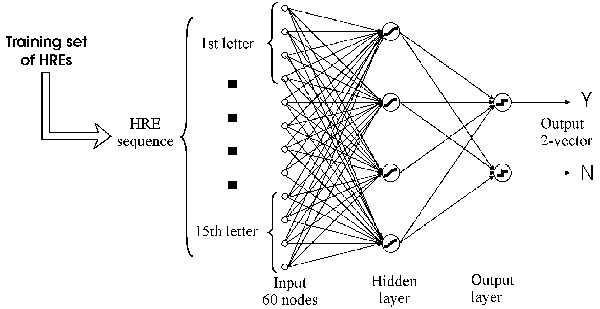
Artificial Neural Network for PRE recognition.